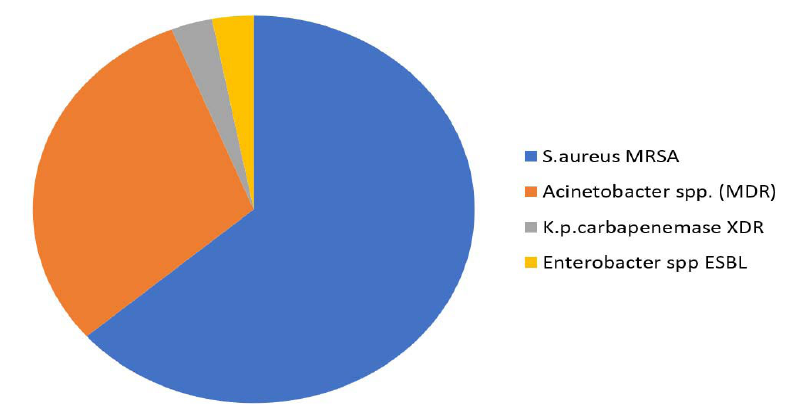
Fig. 9. Multidrug resistant isolates of diabetic foot ulcers